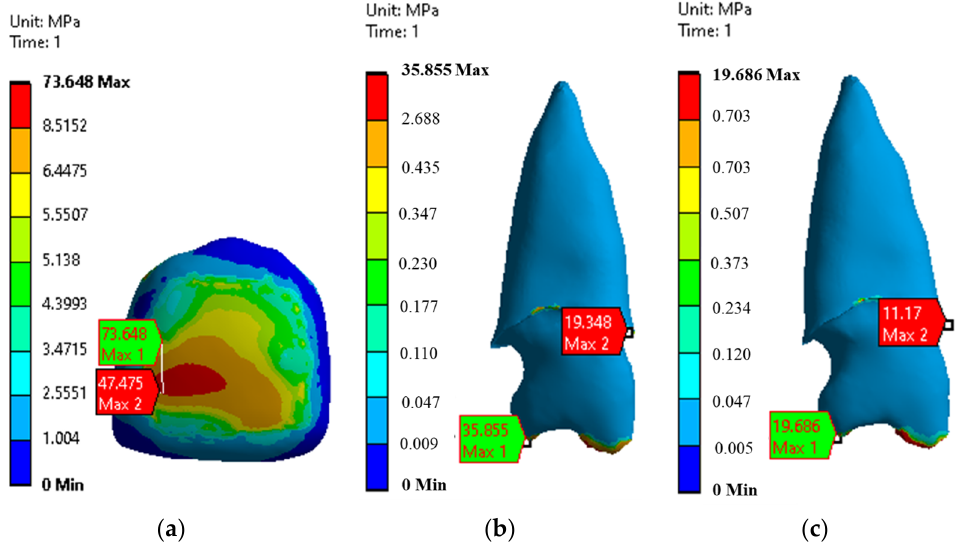
Figure 8. Countours depicting location of maximum values under traumatic load at ( a ) von Mises stress at Enamel, ( b ) von Mises stress at Dentin, and ( c ) shear stress at Dentin.